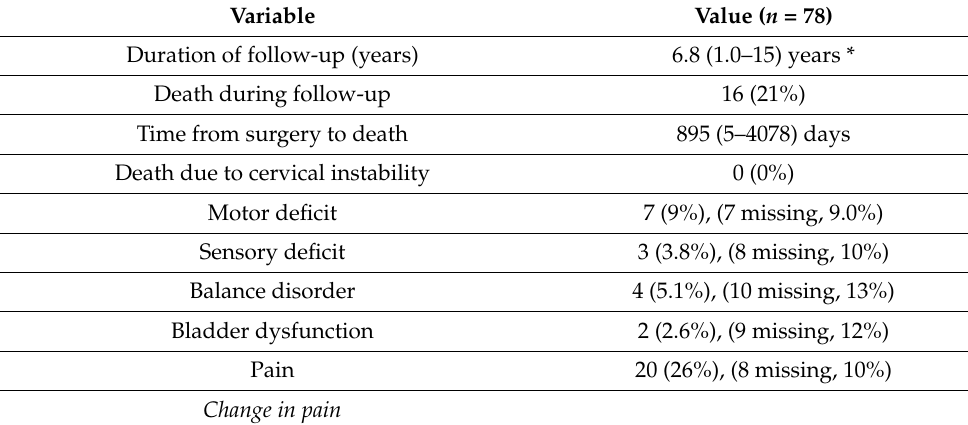
Table 4. Functional